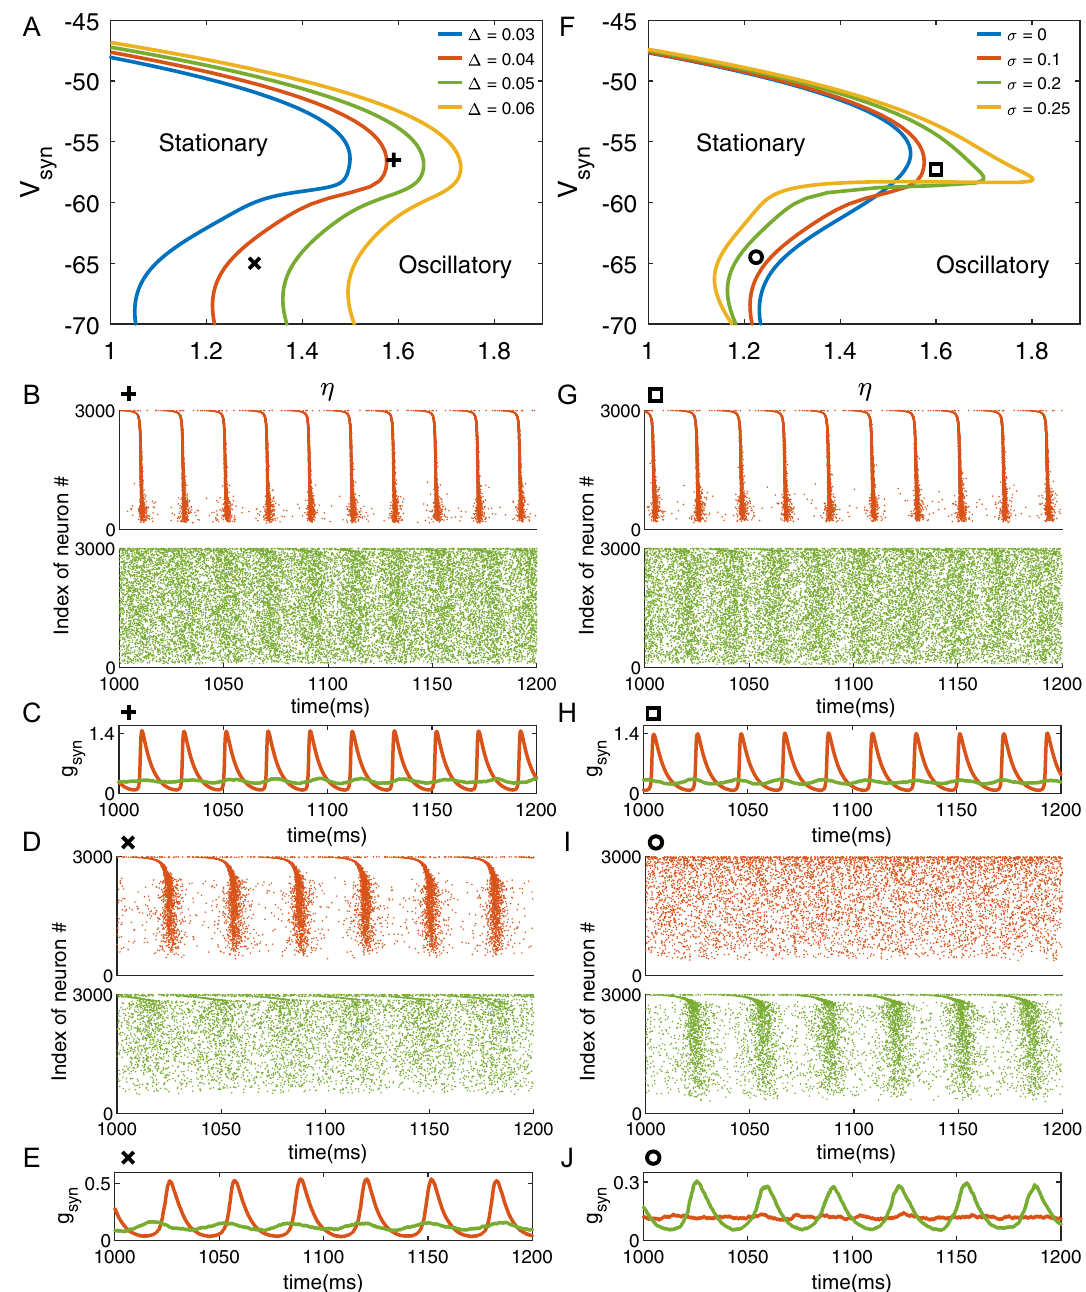
Figure 1. Distinct roles of heterogeneity and noise in ( η , V syn ) plane ( A ), ( F ) 2-D Bifurcation diagrams of the two-cumulant model [Eqs. (2), (3) and (4)] with different (cid:31) or σ . The two regions marked “Stationary” and “Oscillatory” correspond to different dynamic modes: the region of the stationary state and that of the limit- cycle oscillation, respectively. The plus sign, multiplication sign, square and circle denote four different positions on the parameter plane. ( A ) The four curves are all plotted under P syn = 0.1, σ = 0.1 , but with different values of heterogeneity (cid:31) . ( F ) The four curves are all plotted under P syn = 0.1, (cid:31) = 0.04 , but with different values of heterogeneity σ . ( B ), ( D ), ( G ), ( I ) Raster plot of four marked positions, obtained from numerical simulation [Eqs. (1) and (2)]. ( C ), ( E ), ( H ), ( J ) Time-courses of g syn at four marked positions, obtained from numerical simulation [Eqs. (1) and (2)]. All bifurcation diagrams of macroscopic model are plotted with XPPAUT 37 . All numerical simulations of the microscopic model are generated by MATLAB (2019b, http:// www. mathw orks. com/ produ cts/